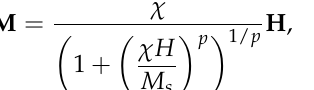
Figure 9. Magnetization curves for polycrystals.